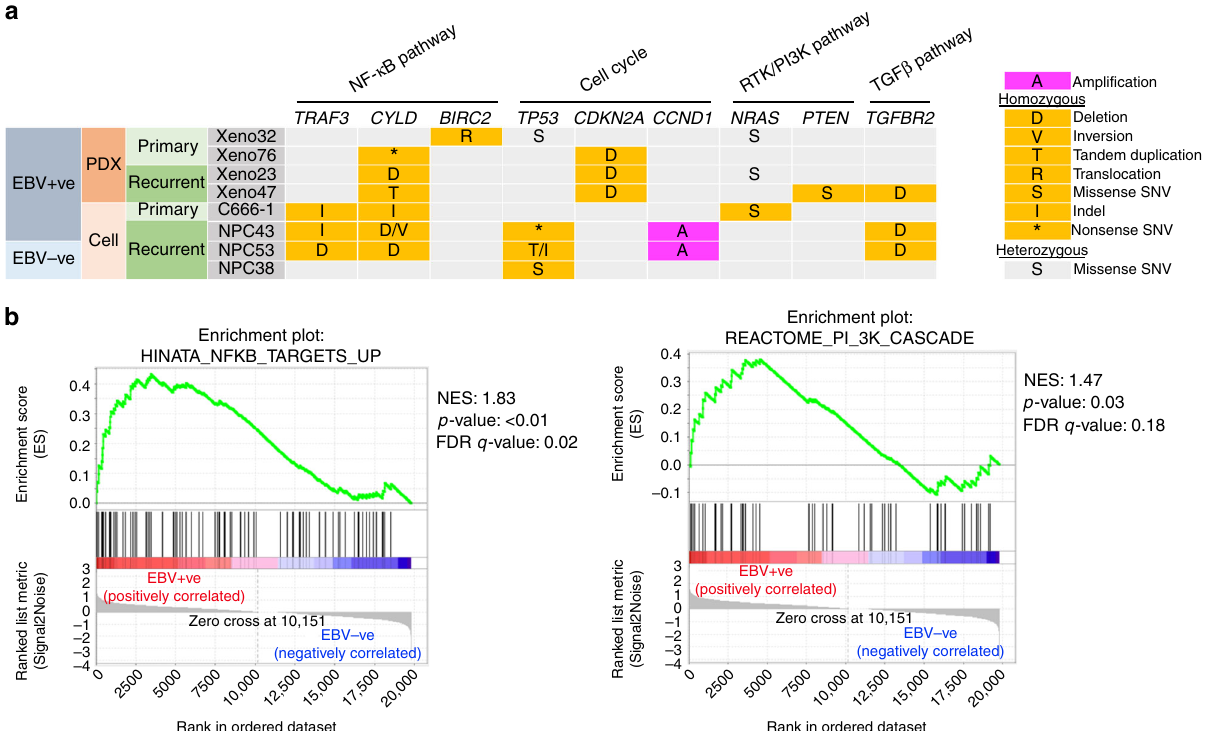
Fig. 8 Mutations of key oncogenic pathways in NPC tumor lines. a Genetic landscape in NPC PDXs and cell lines. Somatic mutations in the newly established PDXs/cell lines and C666-1 are illustrated in mutation plot. Gray box with character inside indicates heterozygous mutation, while orange box with character(s) inside indicates homozygous mutation. S, missense single-nucleotide variant (SNV); D, deletion; V, inversion; T, tandem duplication; I, indel; *, nonsense SNV. b Activation of NF- κ B and PI3K pathways in EBV + ve NPC xenografts and cell lines by transcriptome study. Gene expression levels were quanti fi ed by RNA sequencing and subjected to GSEA for pathway enrichment analysis. Enrichment score (ES) indicates the degree to which the speci fi ed gene sets are overrepresented at the top/bottom of a ranked list of total protein-coding genes in individual PDX/cell line. Normalized enrichment score (NES) computes density of modi fi ed genes in the dataset with random expectancies, normalized by gene numbers found in each gene cluster. False discovery rate (FDR) is calculated by comparing actual data with 1000 Monte-Carlo simulations. For each enrichment plot, top portion: running ES for the speci fi ed gene set; middle portion: where the member of gene set appears in the ranked list of all protein-coding genes; bottom portion: value of the ranking metric as a measurement of gene ’ s correlation with phenotype (EBV + ve or EBV – ve) University of Hong Kong) 4,39 . The cells were maintained at 37°C with 5% CO 2 in humidi fi ed air. DNA extraction . DNA from PDXs and cell lines was extracted using DNeasy ® Blood&Tissue Kit (Qiagen) in accordance with the protocol recommended by the manufacturer. The purity and concentration of the extracted DNA were deter- mined by NanoDrop2000 (ThermoFisher Scienti fi c).